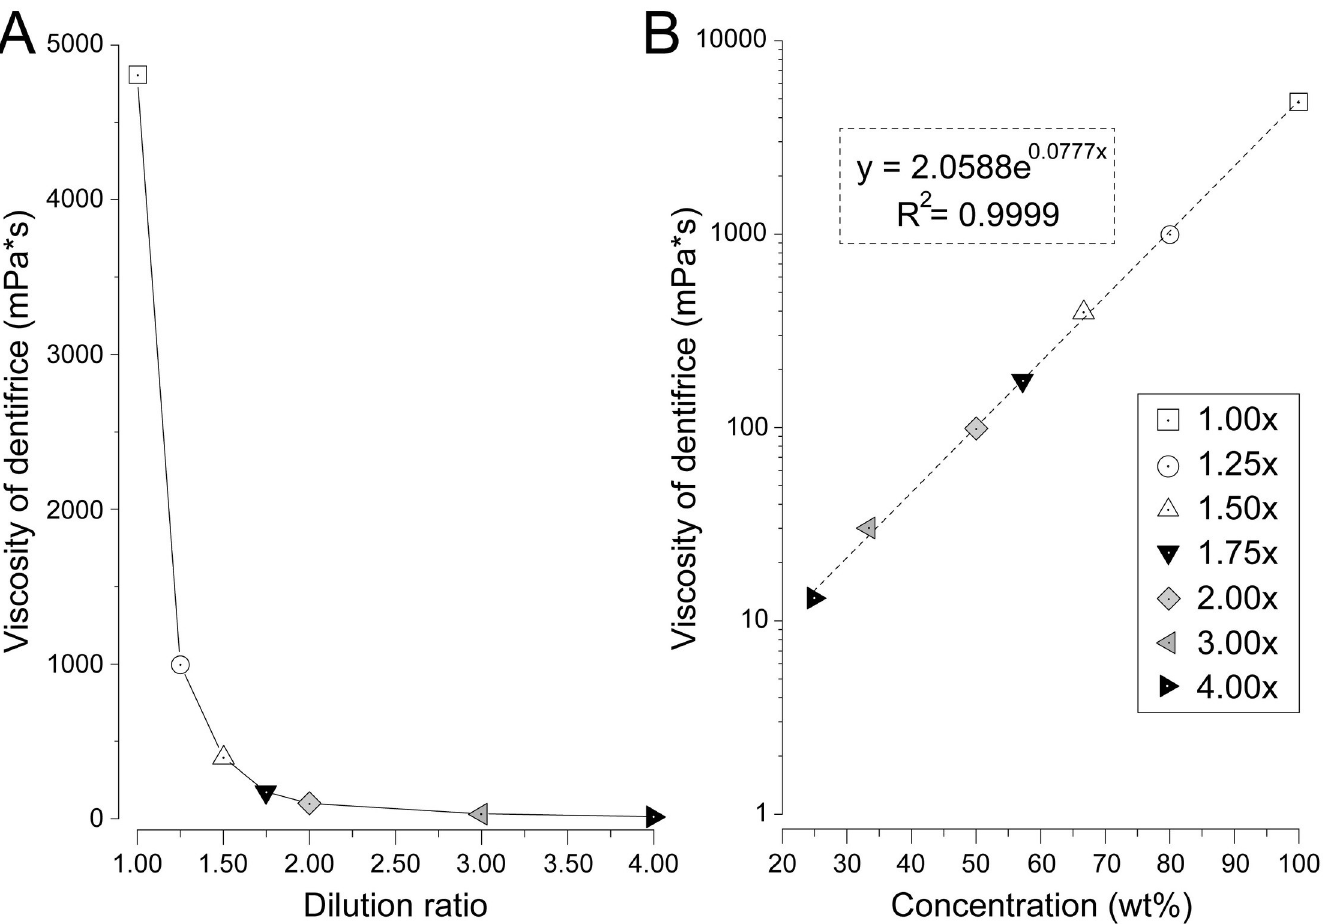
Fig 1. Effect of viscosity according to dilution ratio of toothpaste. (A) Relationship between the dilution ratio of the dentifrice and viscosity. (B) Scatter plot with concentration (wt%) on the horizontal axis and the logarithmic value of the viscosity (mPa � s) on the vertical axis to examine the correlation between the dilution ratio of the dentifrice and viscosity. The dotted straight line shows the approximation and R shows the correlation coefficient.